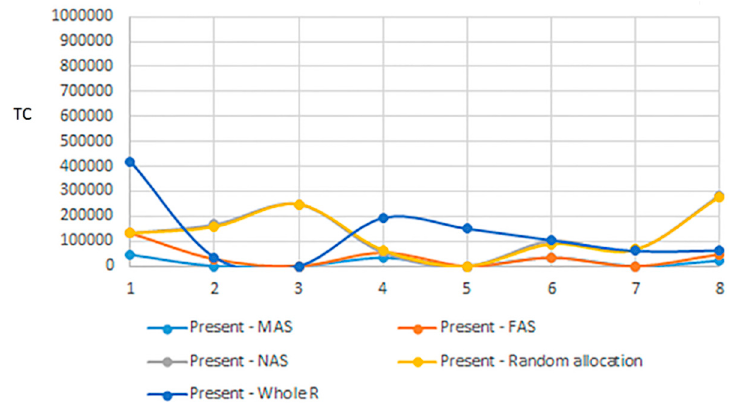
Figure 7. Problem 1, transmission costs with site clustering of this work.